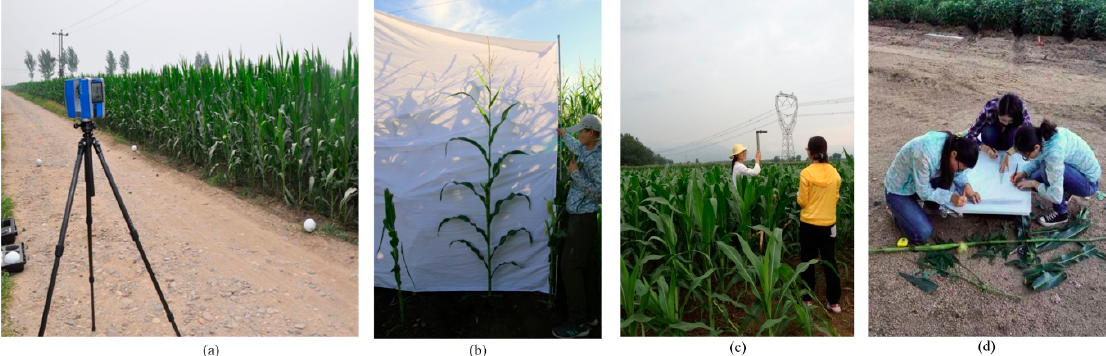
Table 1. The parameters of the FARO Focus3D X330 LiDAR surveying instrument.